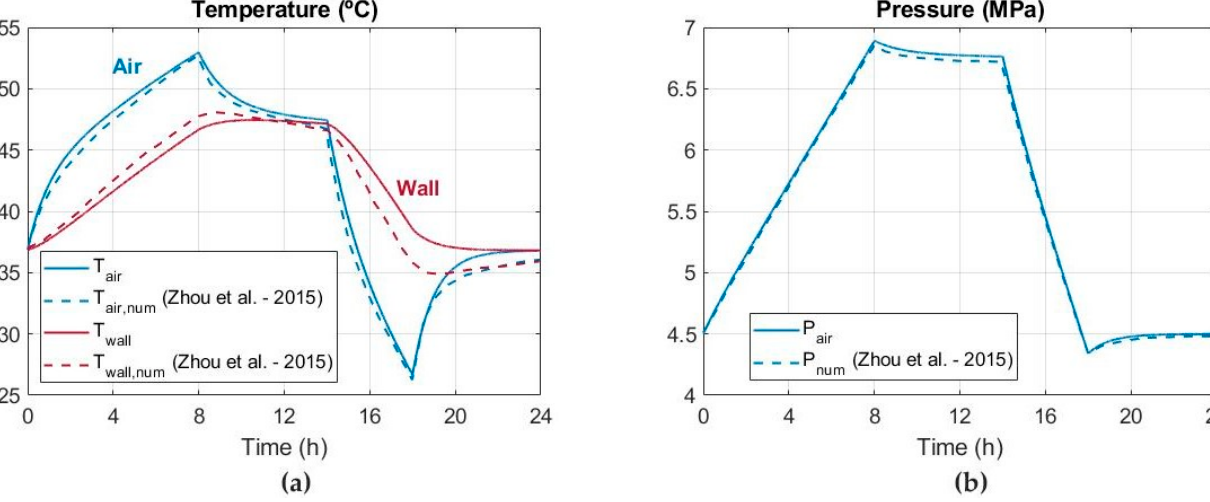
Figure 17. Comparison of results obtained during the first cycle with a numerical model conducted by Zhou et al. [25]. ( a ) Air and wall temperatures; ( b ) Air pressure.